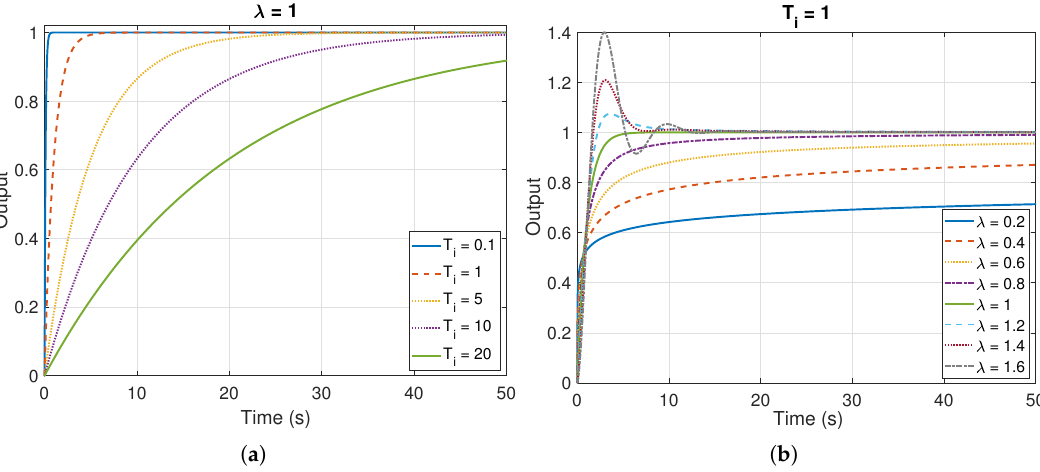
Figure 5. Effects of the automatic reset of the integral action when changing: ( a ) integral time constant T i (integer case) ( b ) integration order λ (fractional